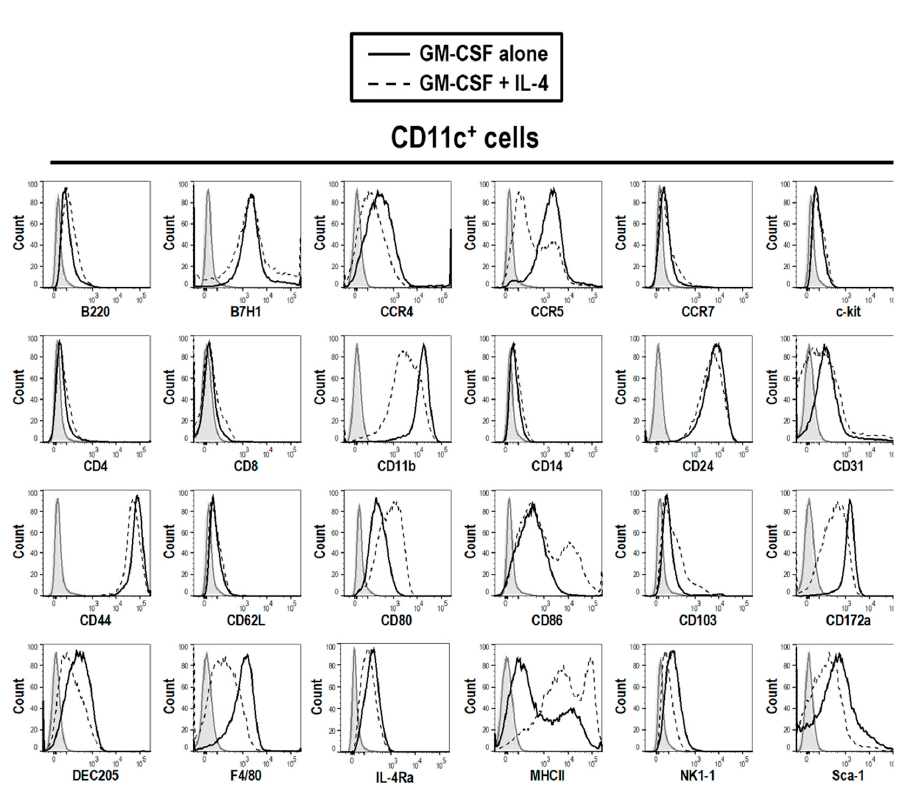
MDSCs express high levels of CD11b (MFI 3827 ± 402.94), but not CD11c (MFI 31.27 ± 0.9), as well as